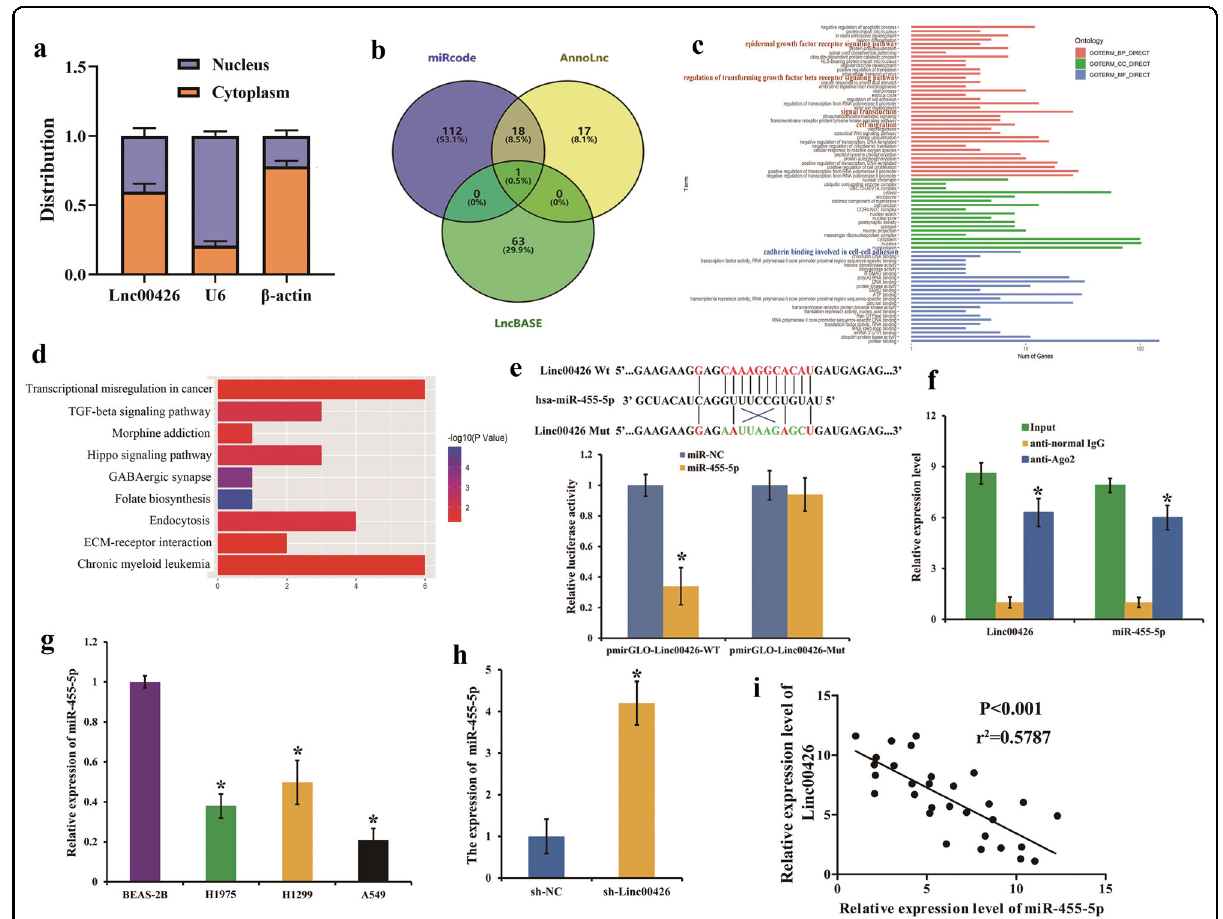
Fig. 4 Linc00426 serves as a ceRNA by competitive binding to miR-455-5p. a Distribution of Linc00426 in A549 cells examined by RT-qPCR. U6 and GAPDH act as nuclear and cytoplasmic internal reference, respectively. b Overlap of miRcode, AnnoLnc, and LncBASE database. c GO analyses. d KEGG pathway analyses. e Predicted Linc00426 binding sites of the human miR-455-5p gene, with the corresponding sequence in the mutated version. Luciferase reporter gene assays are used to prove the interaction between miR-455-5p and Linc00426. Student ’ s t test. f RIP assay. Relative expression levels of Linc00426 and miR-455-5p examined by RT-qPCR. Student ’ s t test. g Expression of miR-455-5p tested in indicated cells by RT- qPCR. One-way ANOVA. h Expression of miR-455-4p in A549 cells with shNC and sh-Linc00426 is detected by RT-qPCR. Student ’ s t test. i Correlation between Linc00426 and miR-455-5p in 30 LUAD tissues ( r 2 = 0.5787, P < 0.001). Spearman correlation analysis. Experiments were performed three times and data were presented as mean ± SD. * P <